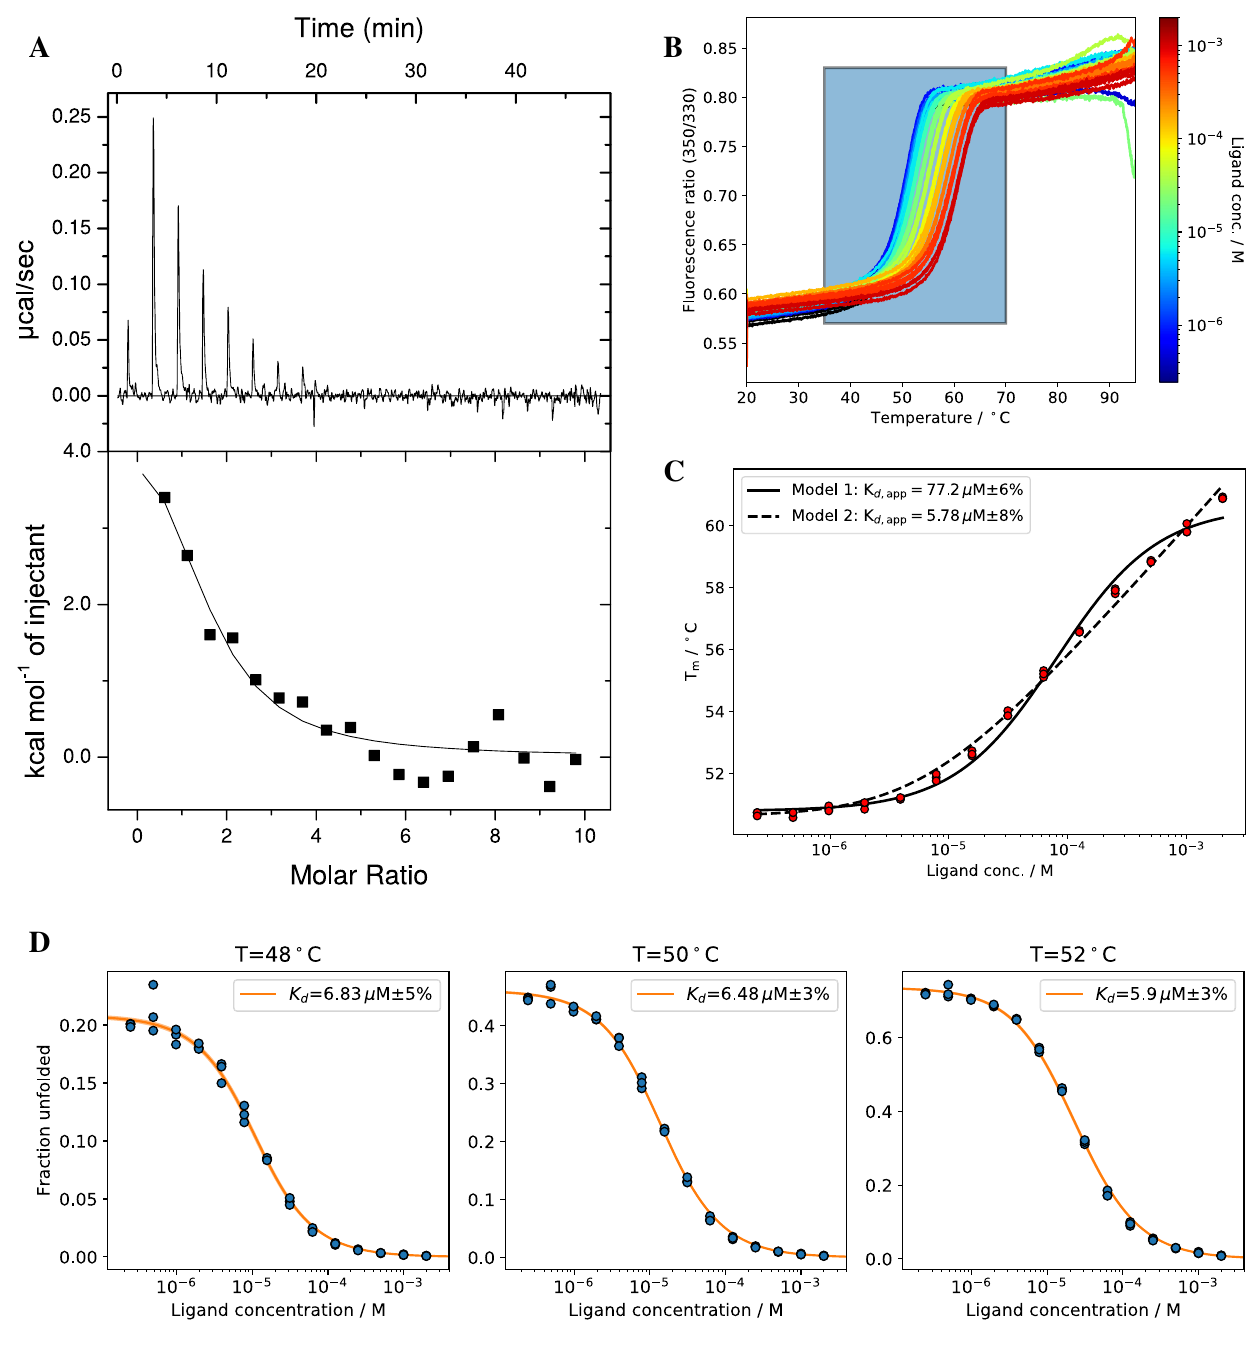
Figure 4. ( A ) The buffer subtracted ITC experiment for SS1/ADPR yields a K d = 3.5 µM ( B ) nDSF signal (fluorescence ratio F 350 / 330 ) for SS1/ADPR binding study. The region in the colored box was used for isothermal analysis (shown in D). The ligand concentrations are color code from blue (low conc.) to red (high conc). The apo protein spectrum in absence of ligand is shown in black. ( C ) Melting temperature analysis with two different models yields apparent K d,app values. ( D ) Isothermal analysis of nDSF data for ∆ C p = 0 at three selected temperatures. The same analysis for a fitted ∆ C p (cf. Table 1) is shown in Supplementary Information